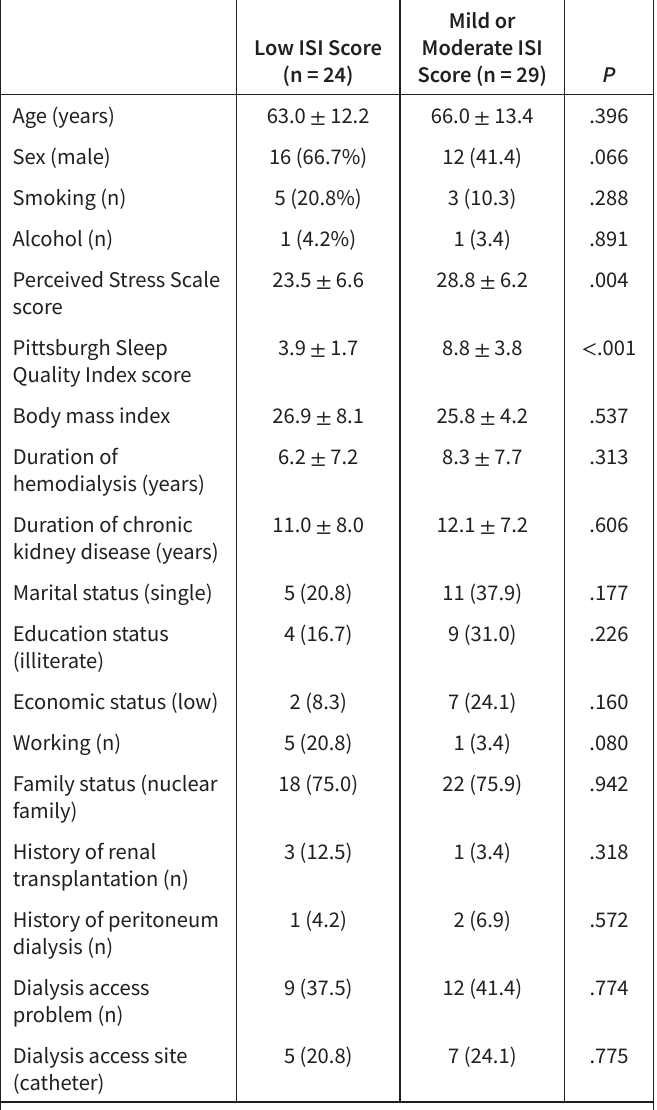
Table 3. Comparison of Baseline Characteristics According to Insomnia Severity Index (ISI).